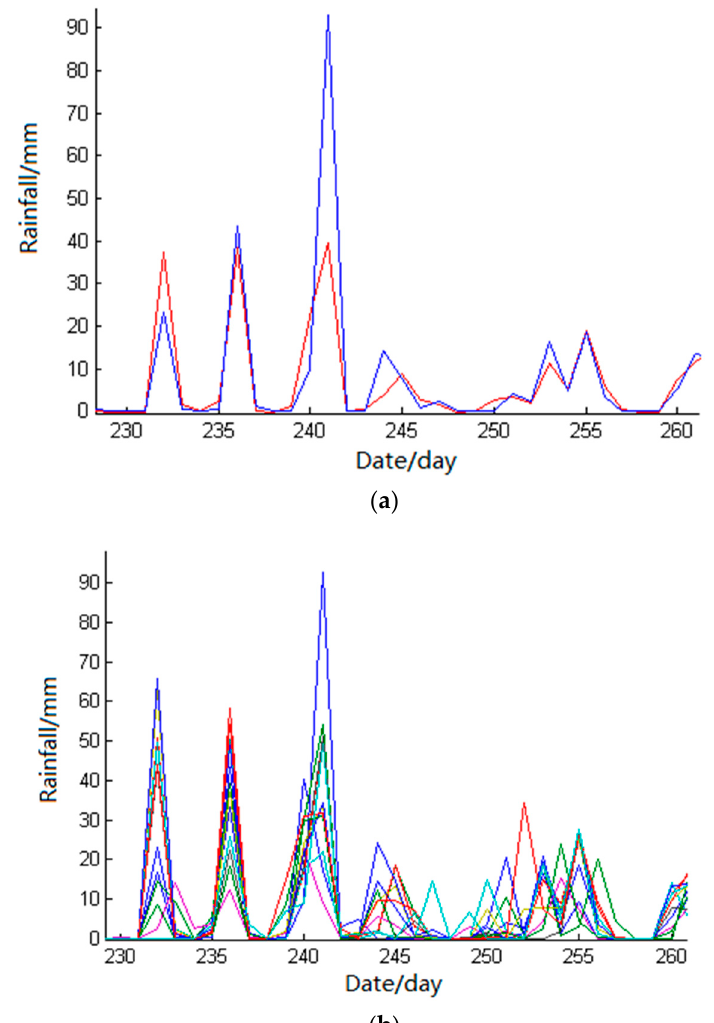
Figure 18. ( a ) Comparison of daily precipitation data between prediction and statistics of Tangyin. ( b ) Comparison of daily precipitation data of stations in the surrounding stations of Tangyin.